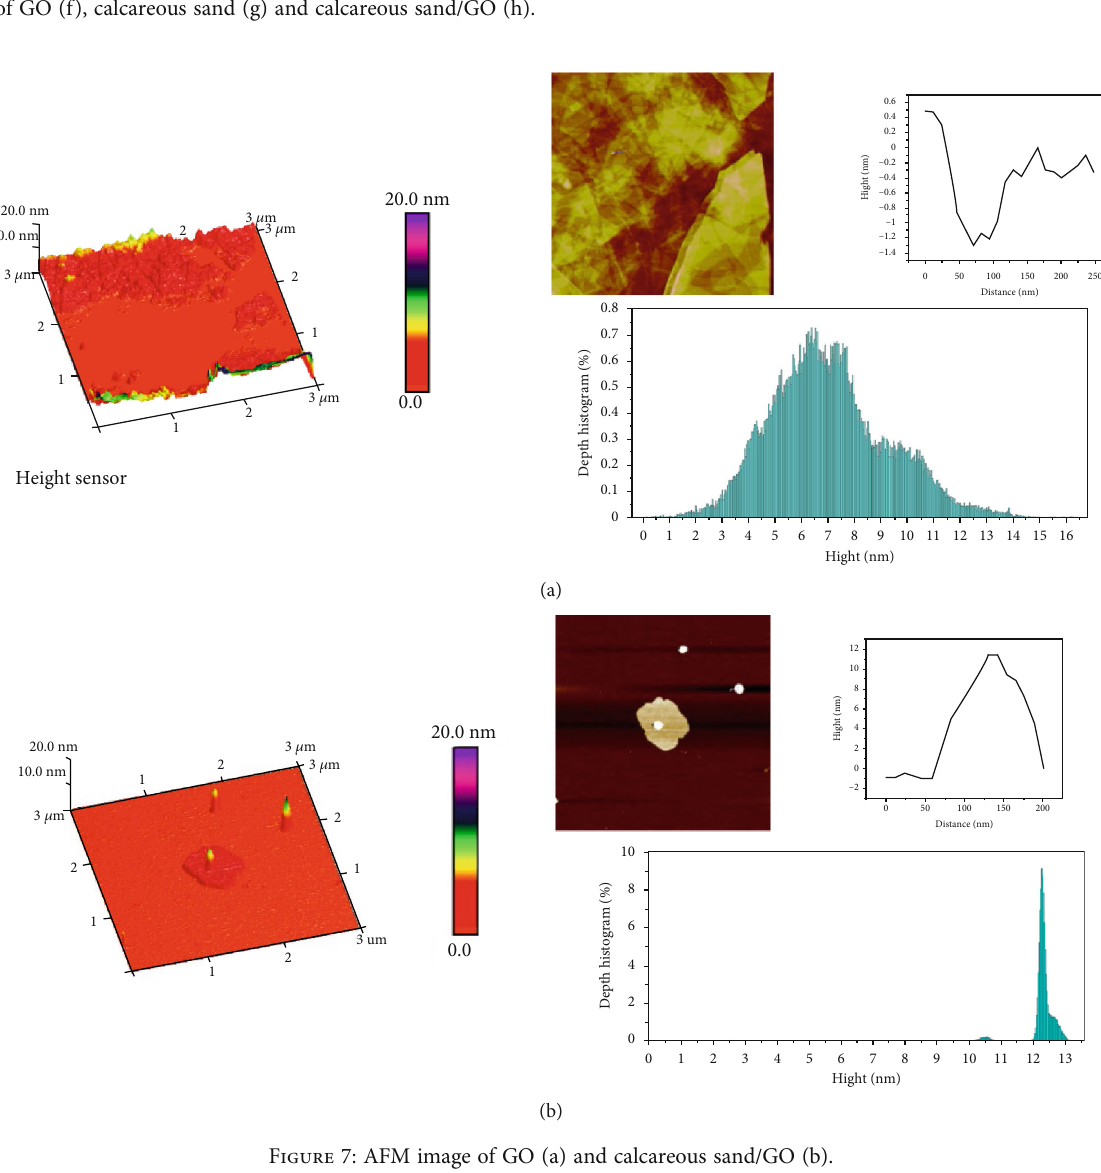
Figure 7: AFM image of GO (a) and calcareous sand/GO (b).